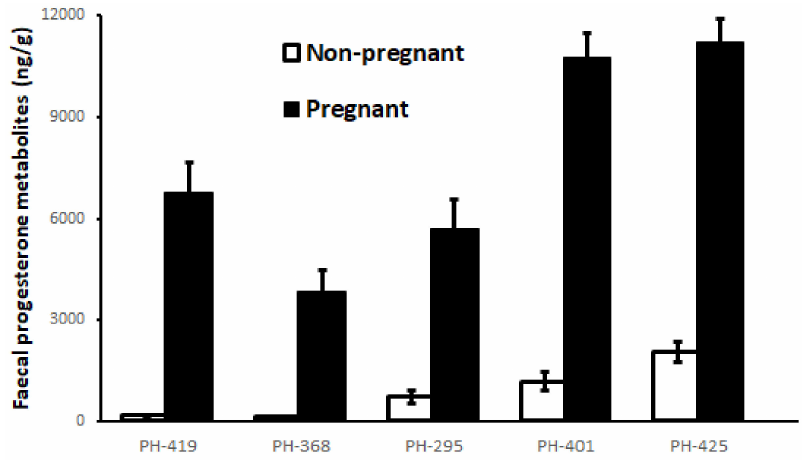
Figure 4. Fecal progesterone metabolite concentrations in pregnant and non-pregnant Pygmy Hog (PH) individuals ( n = 5 females; 523 samples). The pregnant samples included two days after successful mating until delivery, while the non-pregnant samples included non-pregnant periods.